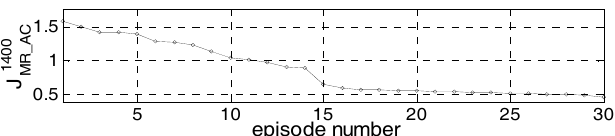
Figure 6. Evolution of 1400 J with each episode for a typical trial of 30 episodes. _ ACMR